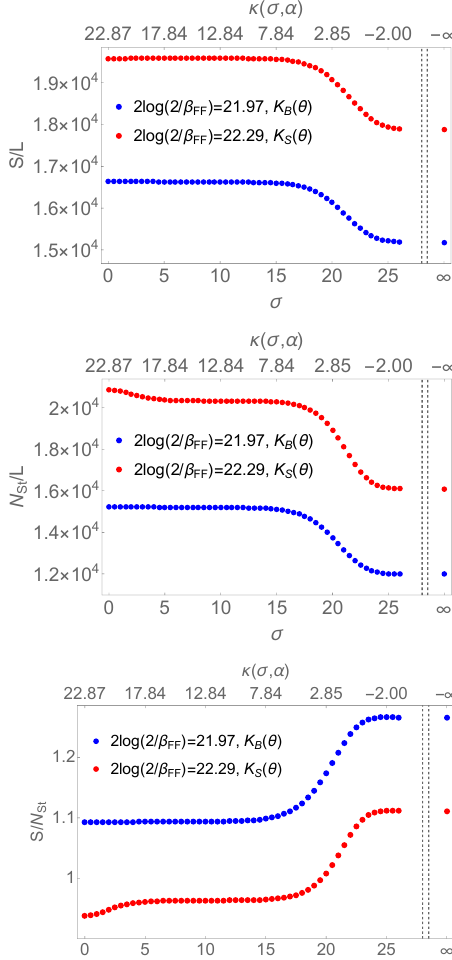
is not unexpected, but a consequence of the fact that all functions depend solely on the universal scale κ α, σ q . This is very clearly illustrated in figure 6 for the function S { L i p normalised by its local maximum value S L . Similar plots can be done for N max { and S { N st